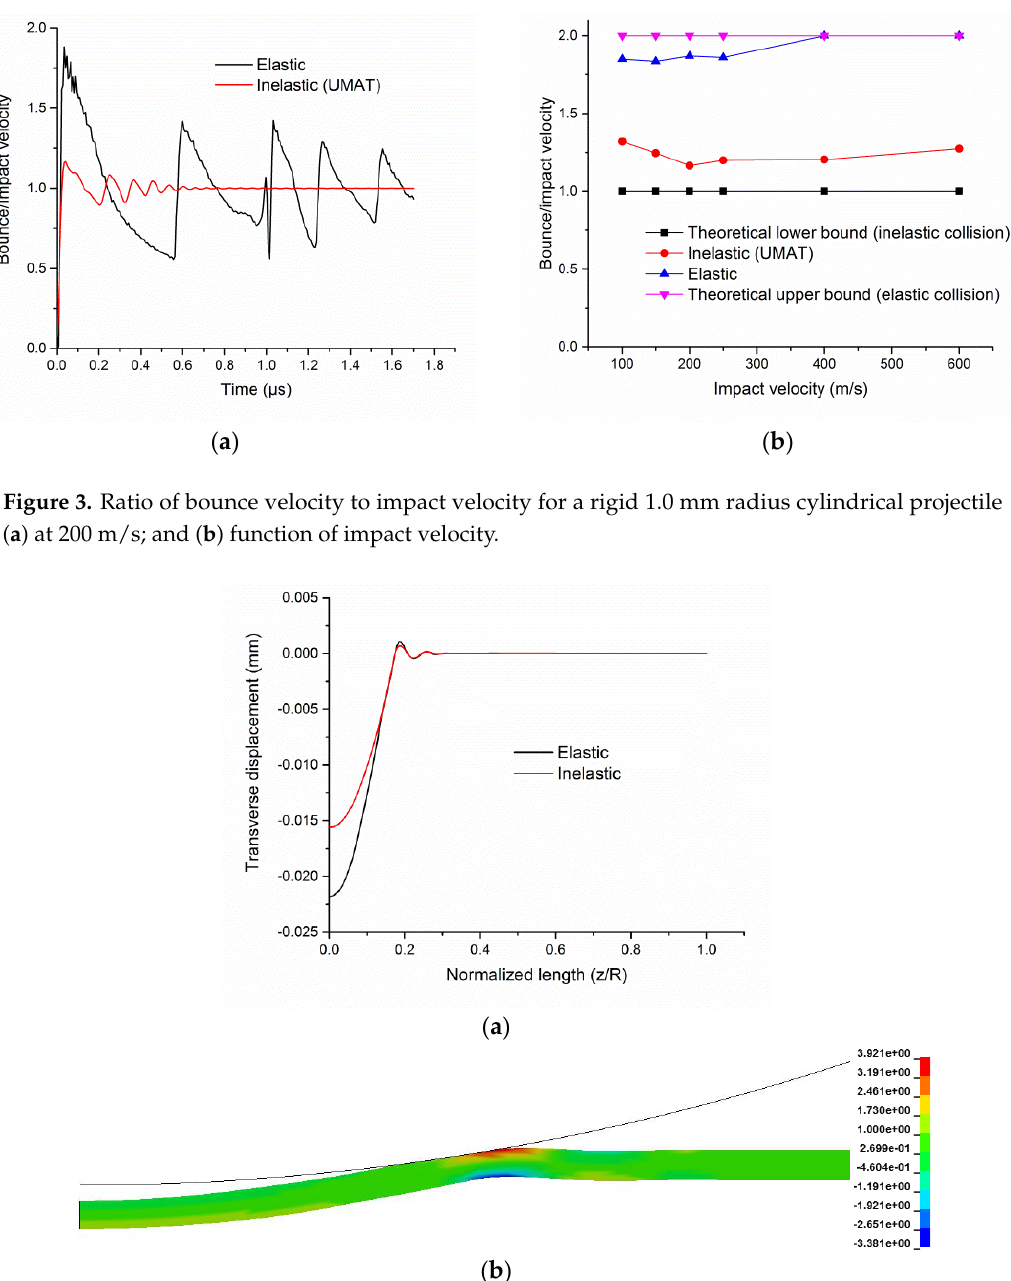
Figure 3. Ratio of bounce velocity to impact velocity for a rigid 1.0 mm radius cylindrical projectile ( a ) at 200 m/s; and ( b ) function of impact velocity.